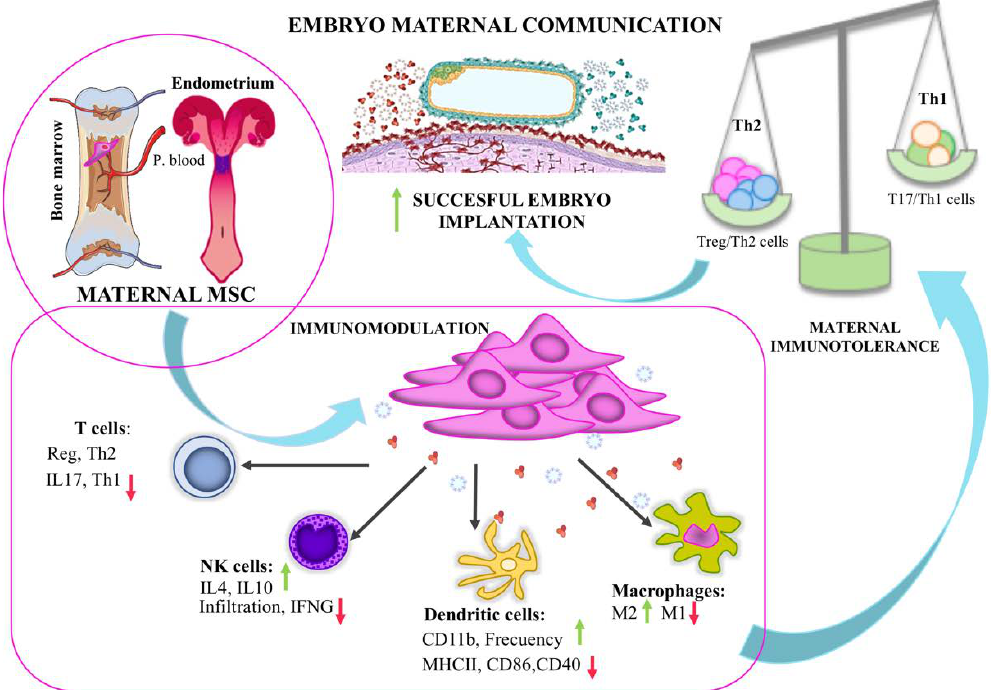
Figure 1. Maternal MSC immunomodulation at the embryo implantation site. The existence of MSC in the reproductive tract is associated with maternal immunoregulation during embryo implantation. MSC exerts immunomodulatory functions in the local environment through cell-to-cell contact or by secreting EV and soluble factors that interact with local immune cell populations, resulting in a shift to a Th2 maternal response.